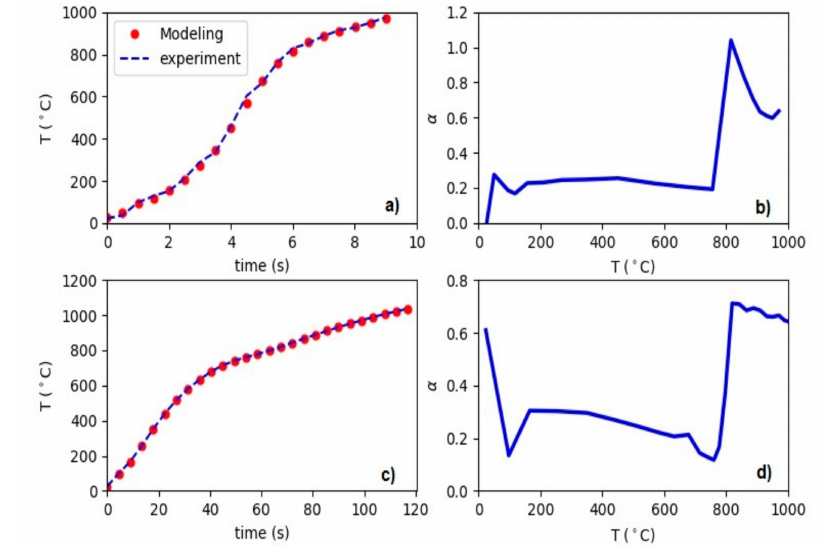
Figure 5. ( a ) Calibration of the model to the measurement data of the experiment done with 13.5 kW of power. ( b ) The optimized parameter α for the experiment with 13.5 kW of power. ( c ) Calibration of the model to the measurement data of the experiment done with 2.1 kW of power. ( d ) The optimized parameter α for the experiment with 2.1 kW of